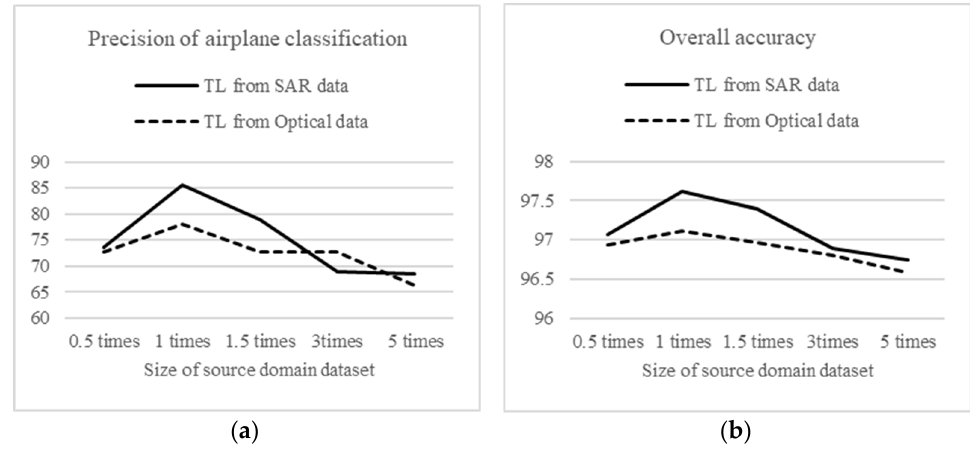
Figure 14. Experimental results of the different sizes of source domain datasets on migration learning: ( a ) Precision of airplane classification; ( b ) Overall accuracy.